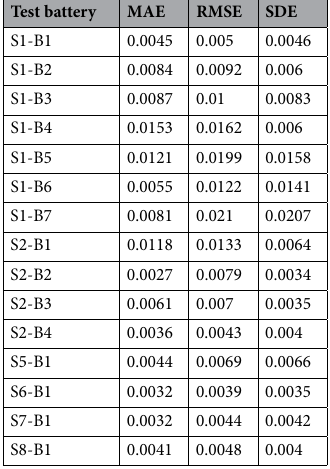
Table 1. SOH estimation results for laboratory data